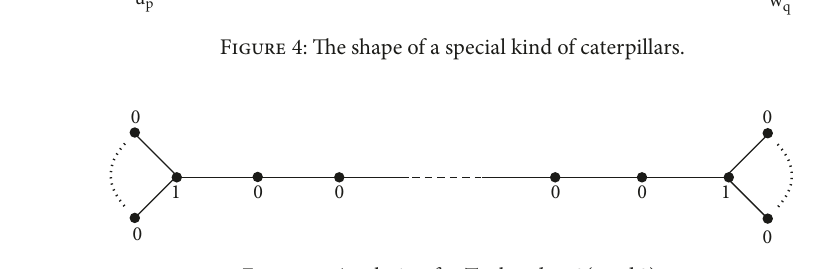
Figure 5: A solution for 𝑇 when 𝑘 ≡ 2( mod 3) .